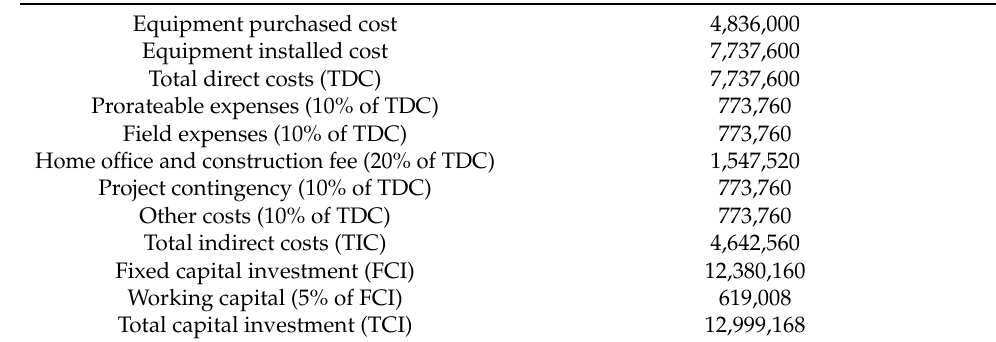
Table 9. Project cost worksheet including total direct costs and total capital investment expressed in USD.